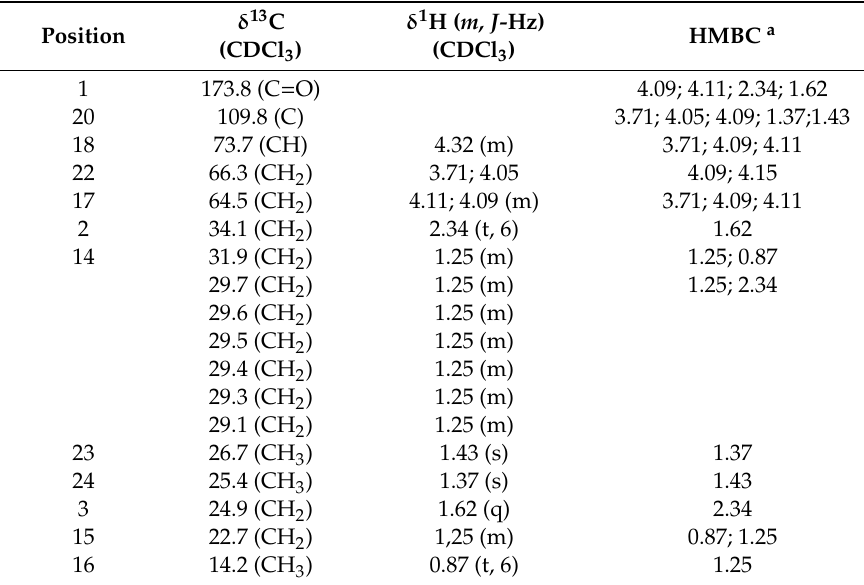
Figure 7. Chemical structure of solketal palmitate. Table 5. 1 H and 13 C NMR data of solketal palmitate.